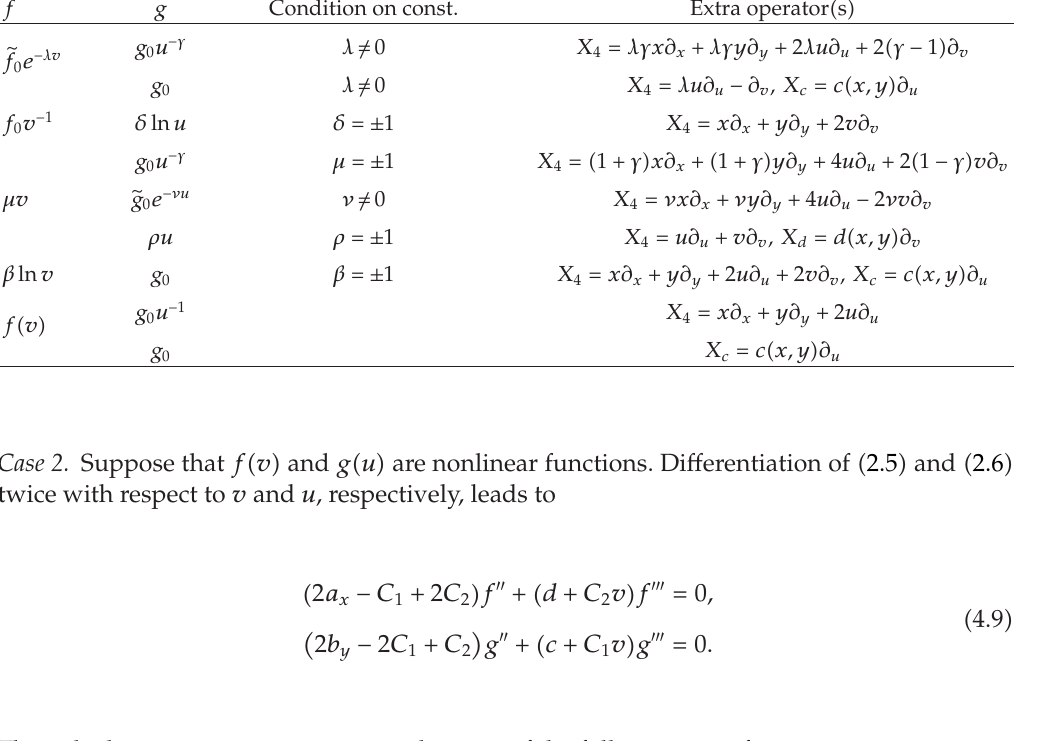
Table 1: Classification results: k / (cid:4) 0 (cid:5) p (cid:4) 0 (cid:6) and k (cid:4) 0 (cid:5) p / (cid:4) 0 (cid:6) . f g Condition on